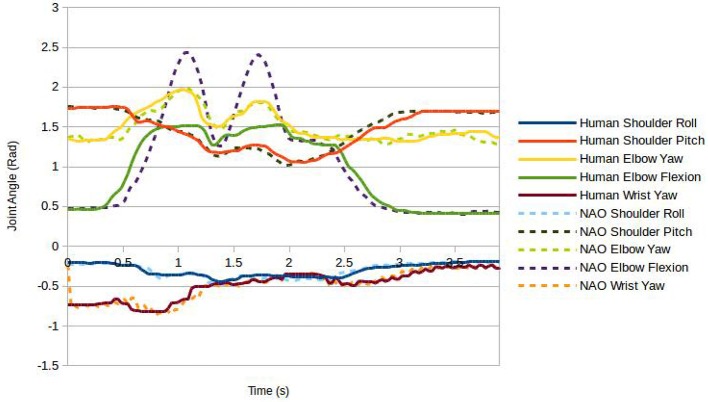
Joint values during the Fixed1 gesture for human and robot performers.